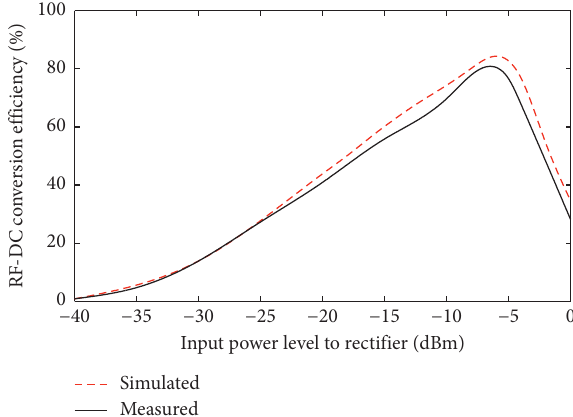
Figure 28: RF-DC conversion efficiency of FM rectifier at 98MHz for 10k Ω